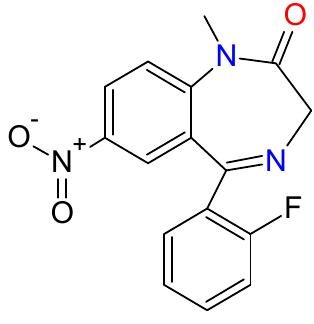
Figure 7. Chemical structure of the benzodiazepine (Flunitrazepam) that, together with insulin, was administered into the victim's mouthwash by the nurses Maria Gruber, Irene Leidolf, Stephanija Meyer, and Waltraud Wagner (the “ Lainz Angels of Death ”), murdering 43 persons in Vienna, Austria.